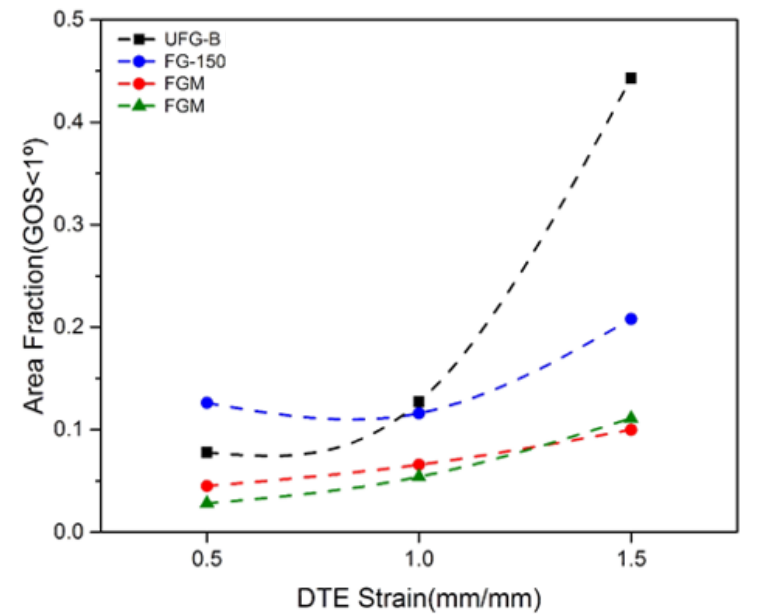
Figure 7. Inverse pole figure (extrusion direction) and GOS maps of FGH Cu at the region of DTE strain level of ( a , d ) 0.5, ( b , e ) 1.0, and ( c , f ) 1.5 in the conical remnant, indicated by red dash lines. The horizontal direction is the DTE direction of the specimen.